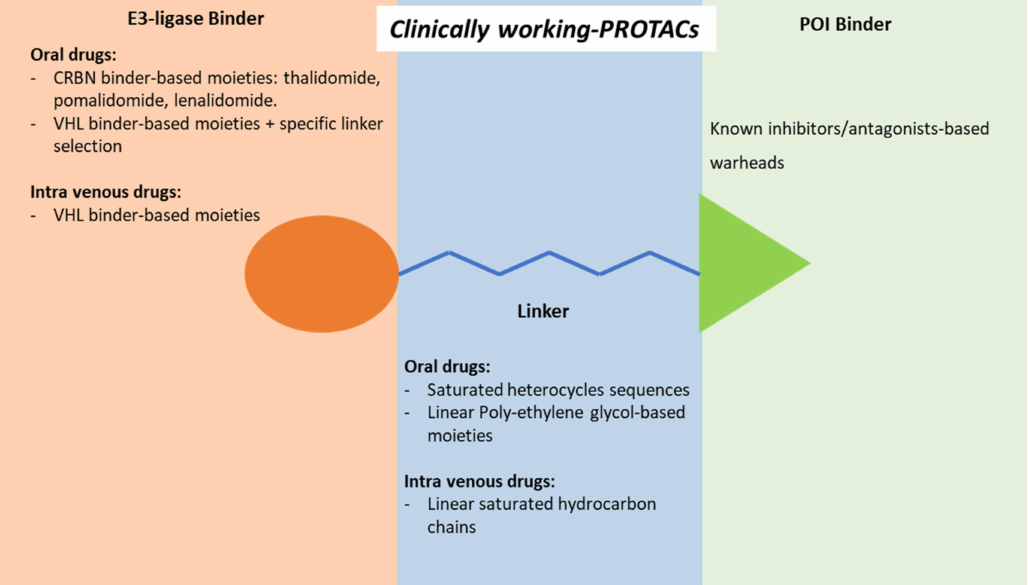
Figure 3. Structural characteristics of Proteolysis Targeting Chimeric molecules (PROTACs) currently in a clinical trial, distinguished by structural moiety and route of